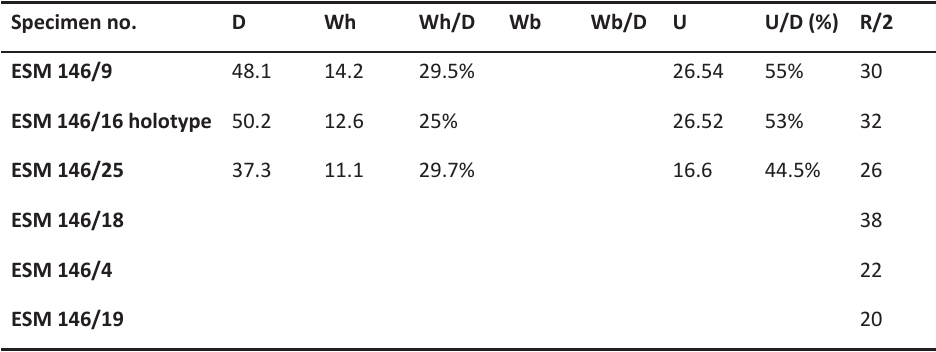
Table 1. Measurements of D. (D.) kopiki Rogov, sp. nov. D – diameter, Wh – whorl height, Wb – whorl